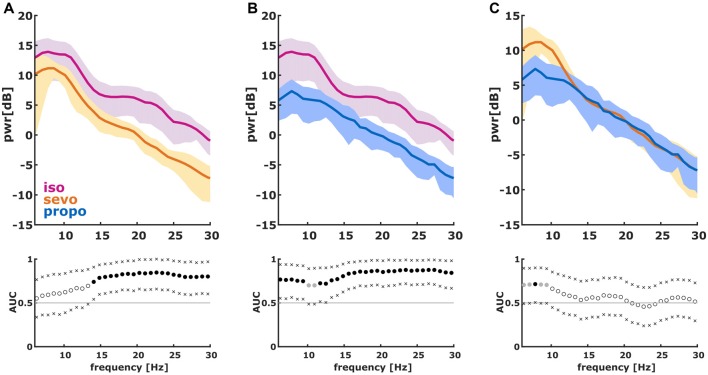
Power spectral density (PSD) in the 6–30 Hz range of the first 2 s of the first burst. (We dismissed the first 100 ms of burst onset to make sure we did not include any suppression). The solid lines present the median and the shaded areas the median absolute deviation for the comparisons of (A) isoflurane and sevoflurane, (B) isoflurane and propofol, and (C) sevoflurane and propofol. In the area under the curve (AUC) plots, a filled circle in black indicates significance and a gray circle indicates a non-significant AUC > 0.7. The non-filled circles indicate AUC < 0.7 with 95% confidence intervals (CIs) inclusive 0.5, i.e., there is no effect. The x indicate the upper and lower limits of the 95% Ci.